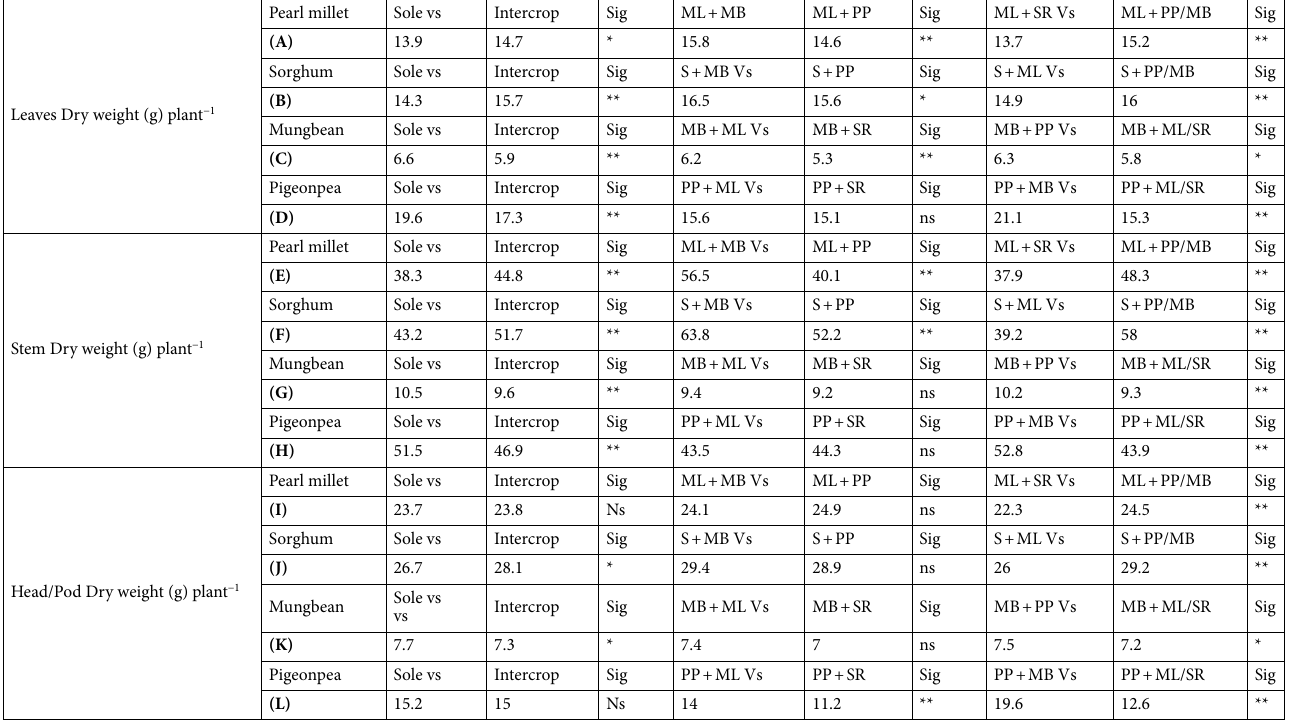
Table 8. Pre-planned comparison of different intercropping systems at physiological maturity of winter crops as affected by intercropping and irrigation regimes. Where *, ** stands for significant at 5 and 1% level of probability, respectively. ML, MB, SR and PP stand for millet, mungbean, sorghum and pigeon pea and W, B, FB, R, stand for wheat, barley, fababean and rapeseed, respectively. Means in the same category are not significantly different if followed by at least one common letter at ( P ≤ 0.05)